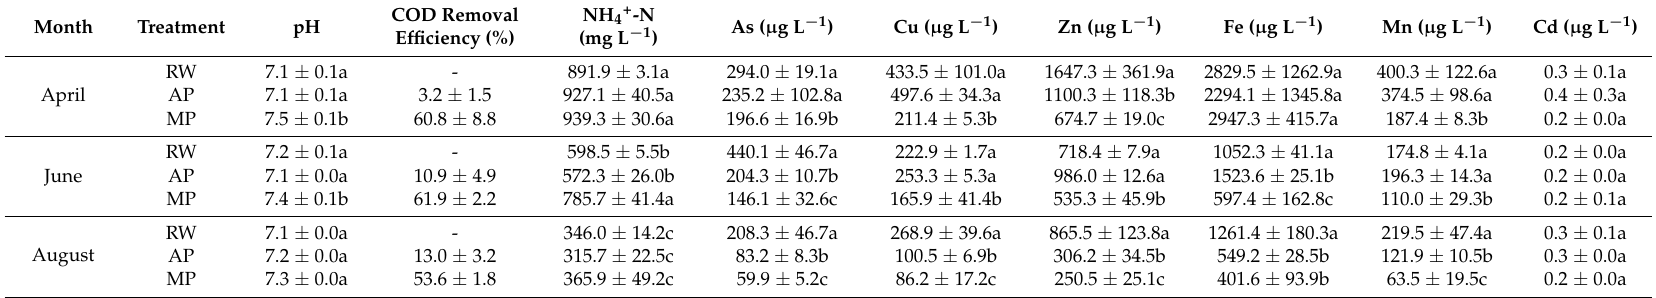
Note: Different lowercase letters in the columns indicate a significant difference among the different samples at p <